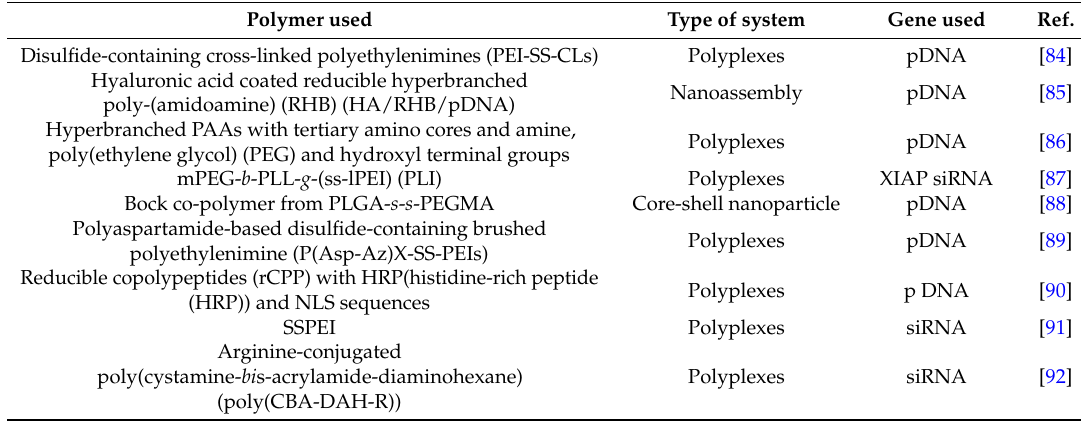
Table 2. Examples of redox-stimuli responsive gene delivery